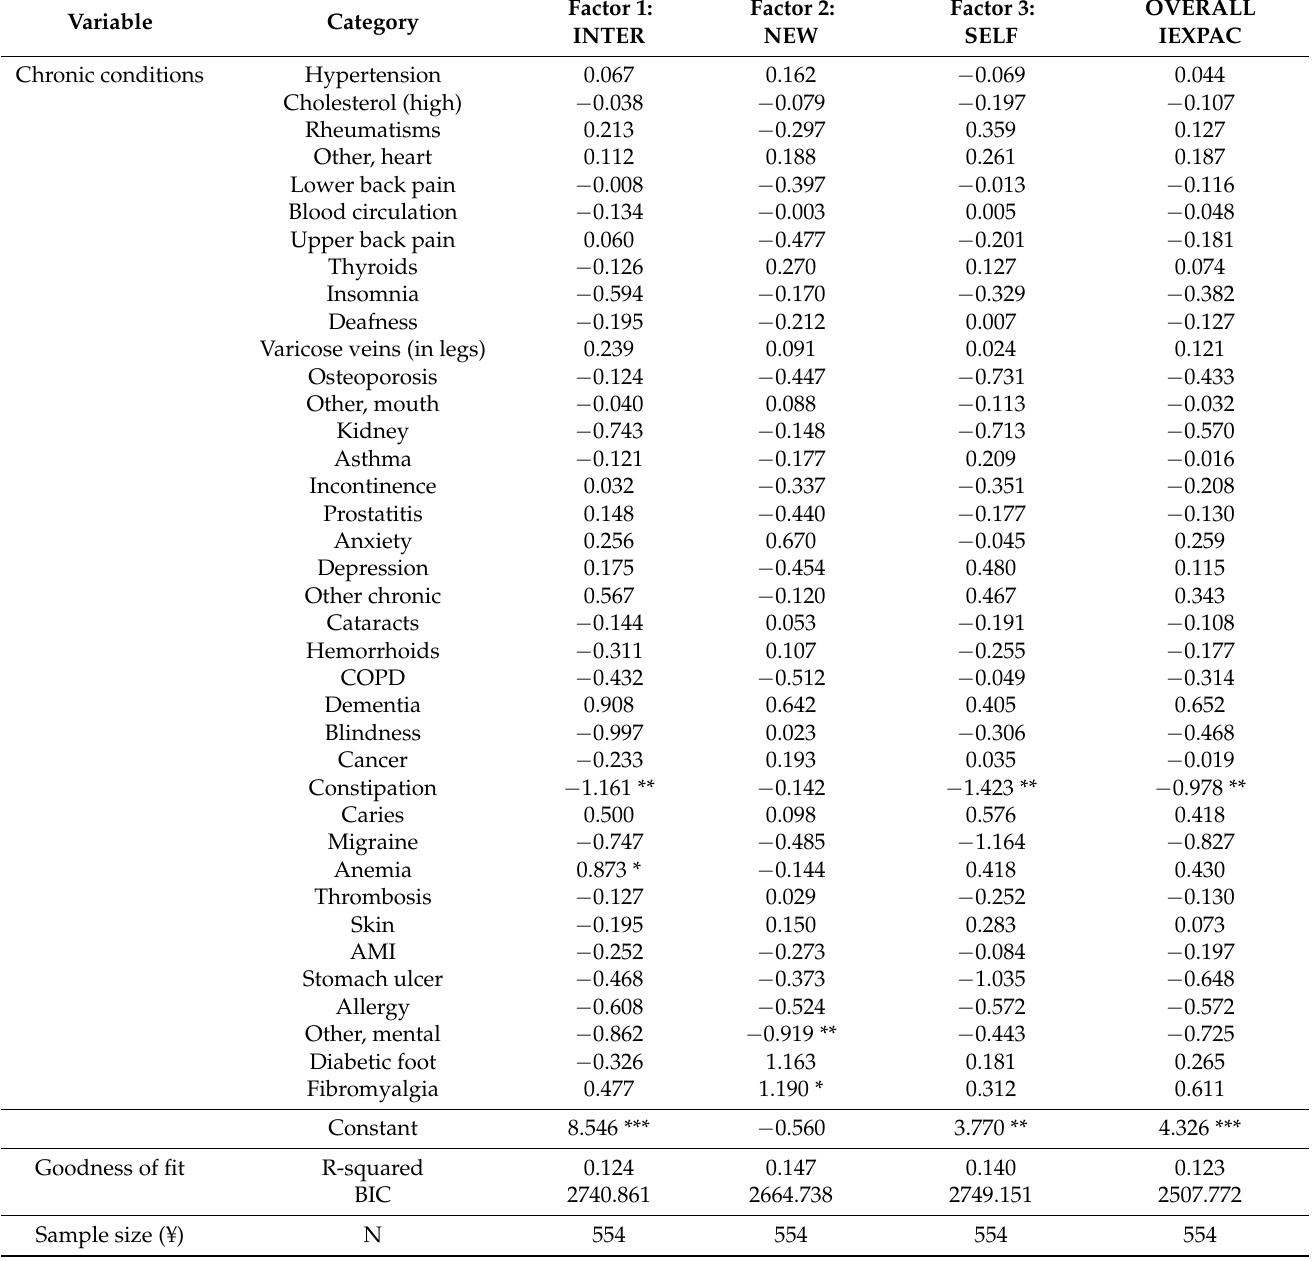
Table 4. Model 2—WLS results. Differences in healthcare experience among patients with self-declared diabetes. The chronic conditions